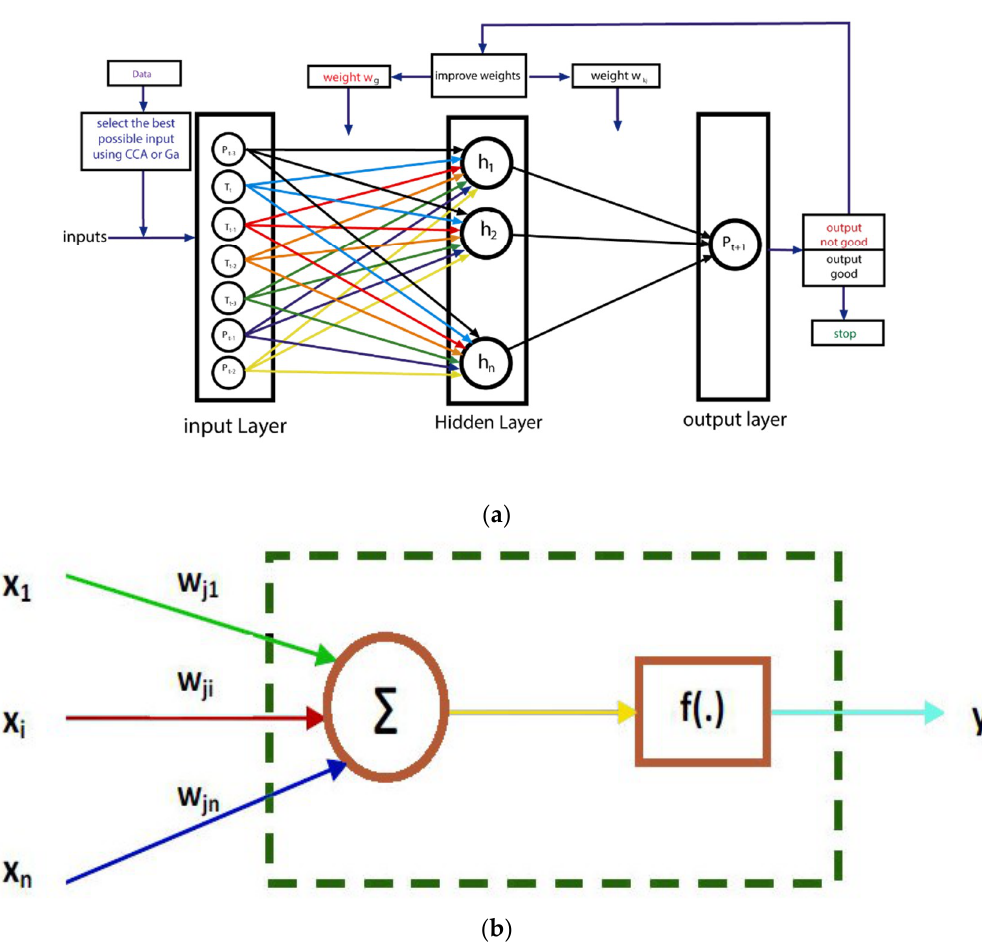
Figure 5. ( a ) Flow chart for MLP (a feed-forward ANN); and ( b ) summation of input signals with weights in neural networking for generating output.